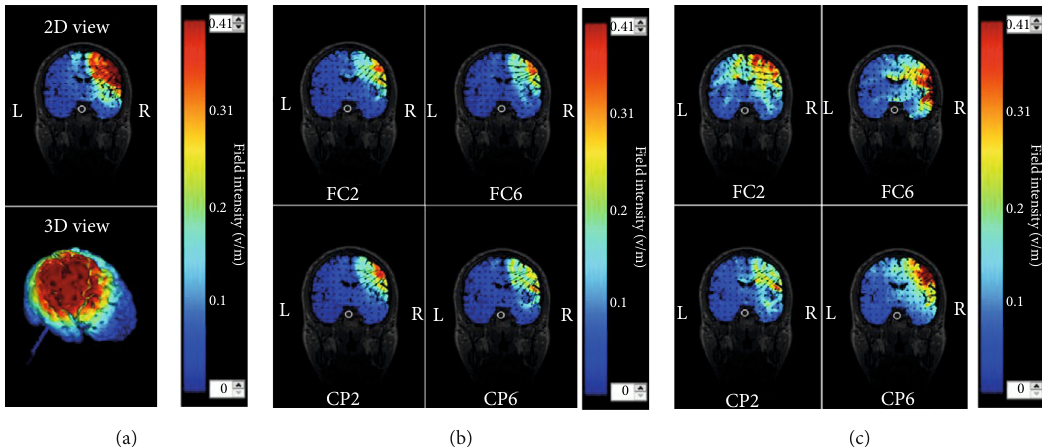
Figure 3: The electric fi eld distribution for the 4 × 1 HD montage generated by HD-Explore ™ . (a) All four cathodes were valid, (b) one cathode failed, and (c) only one cathode was valid.